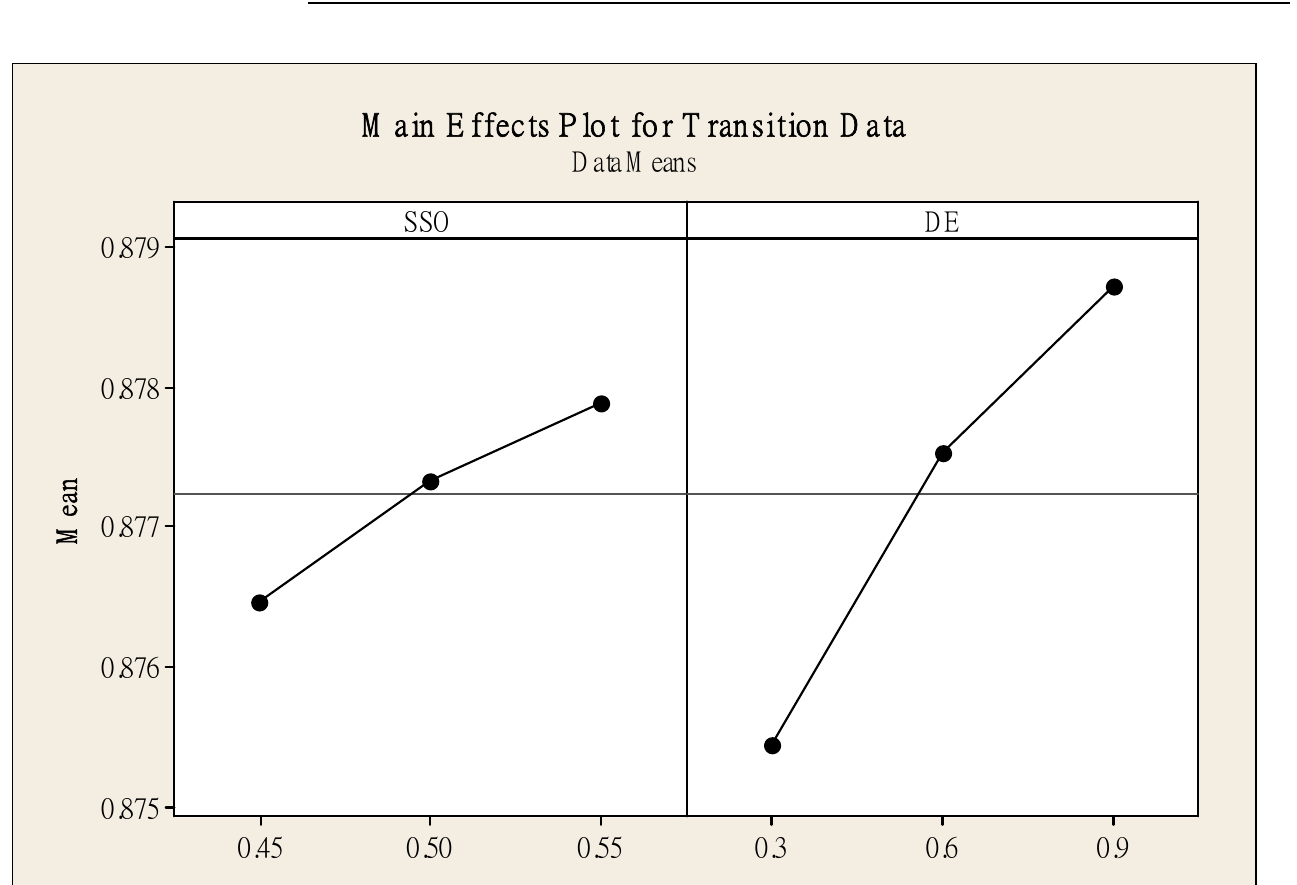
Figure 4. Main effects plot for spring